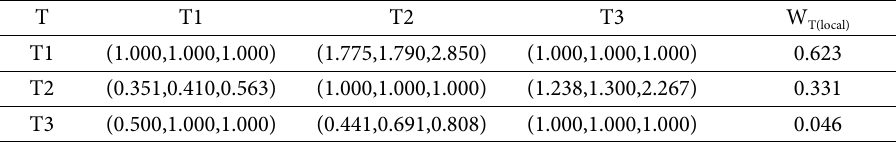
Table 11. Pair-wise comparison matrices and local weights for “T”-factor criteria